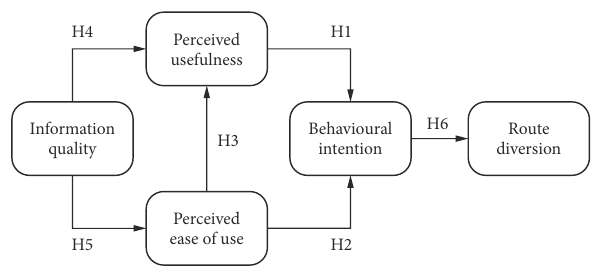
Figure 2. Causal relationships among variables